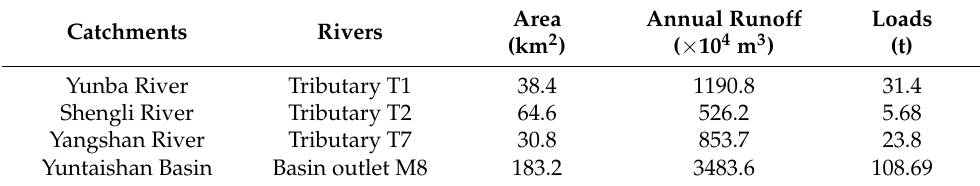
Table 4. Annual nitrate load of each tributary and watershed.